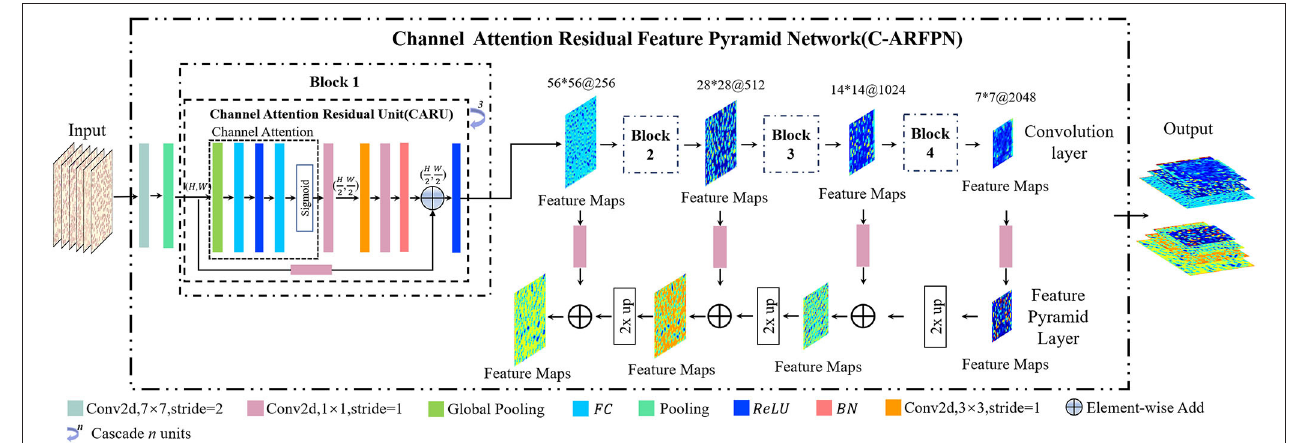
FIGURE 4 | Schematic diagram of the Channel Attention Residual Feature Pyramid Network (C-ARFPN) structure. Resnet-101 is used as the backbone. Channel Attention Residual Units (CARU) are located at the front of each residual congestion unit and stacked in varying numbers to form residual